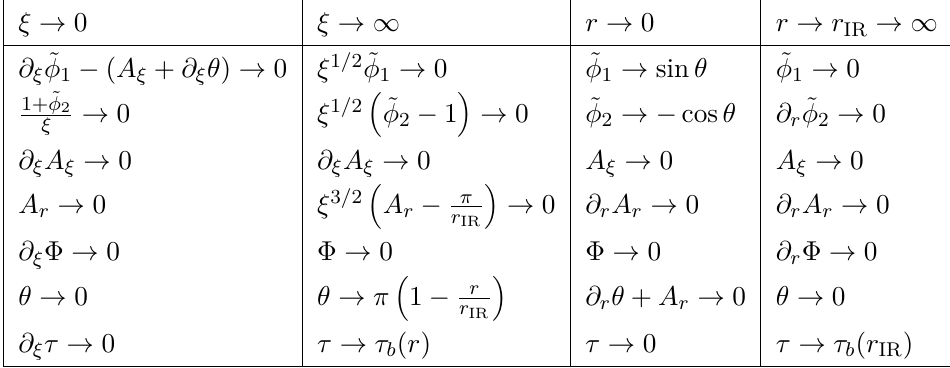
Table 2 . Boundary conditions in Lorenz